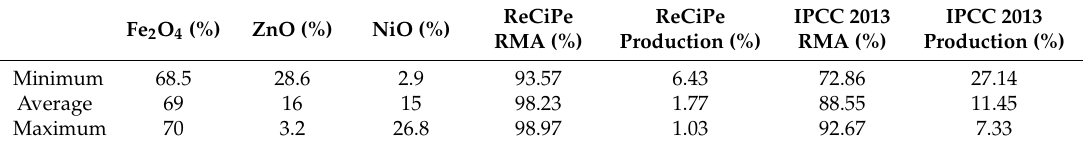
Table 11. RMA and production percentages for minimum, maximum, and average NiZn soft ferrite.